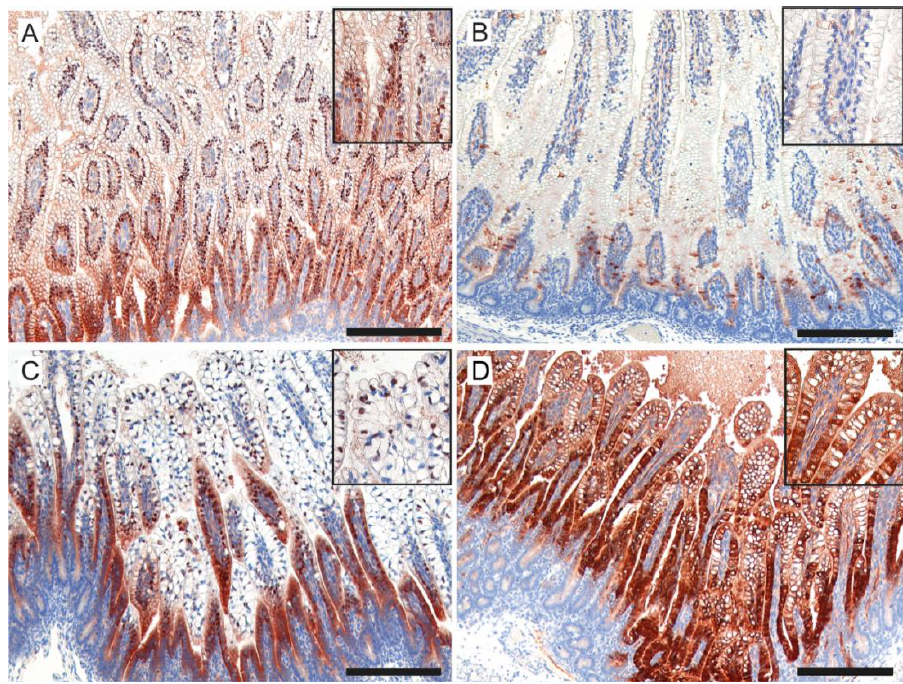
Figure 8. Expression pattern of I-FABP in the ileal gut. (A) In control fetuses, I-FABP expression was present along the crypt – villi axis. (B) This pattern was disrupted in UP-exposed lambs, where I-FABP expression was more localized in the intestinal crypts. (C) The I-FABP expression pattern was restored in most preterm lambs treated with the carrier, without and with (D) plant sterols with a pattern comparable to that seen in the control intestinal samples. Scale bar indicates 200 µm. Abbreviations: I-FABP, intestinal fatty acid binding protein; UP, U. parvum